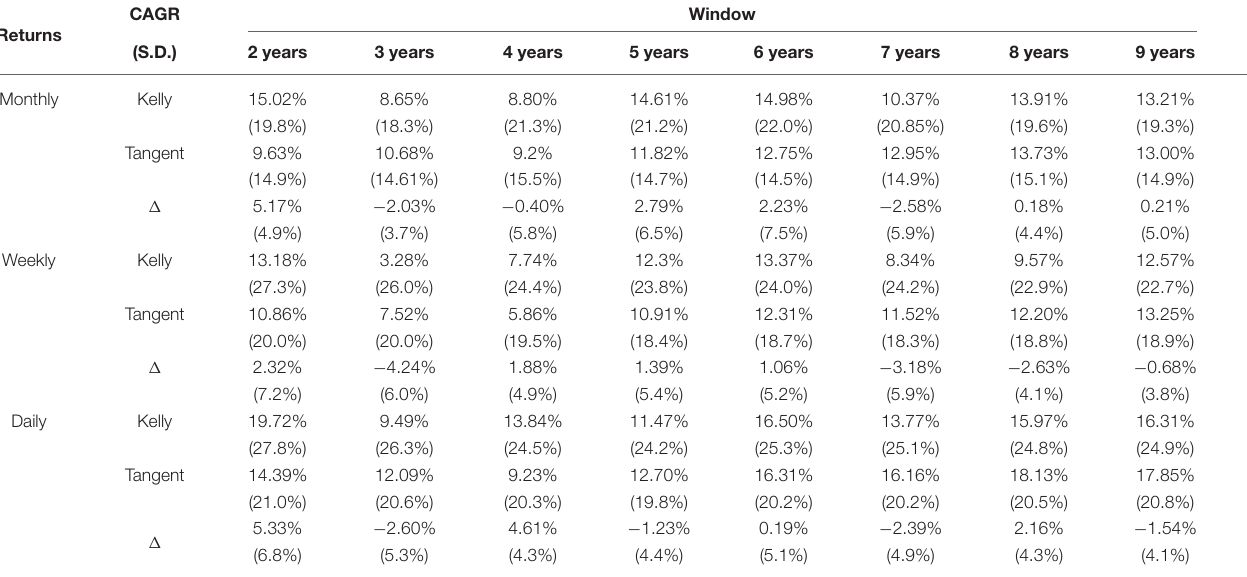
TABLE 9 | Results of the sensitivity